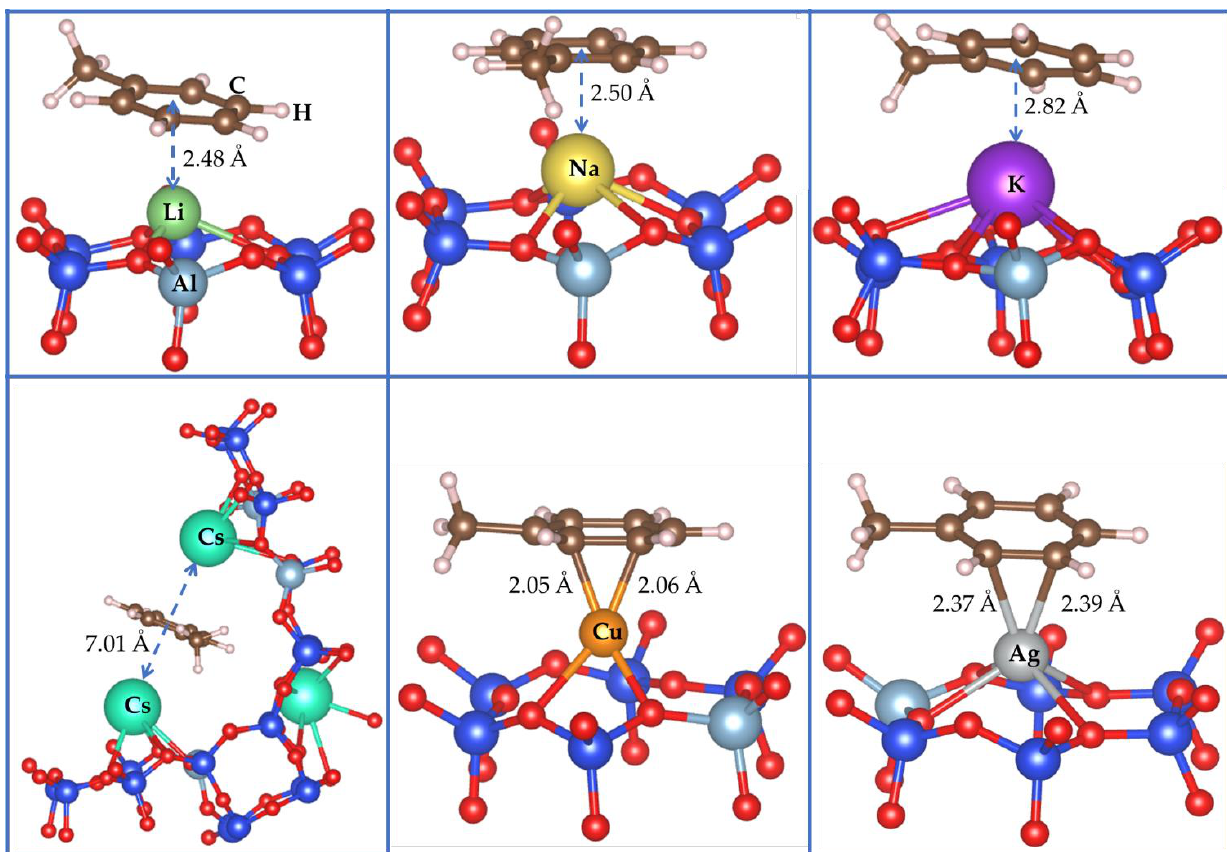
Figure 1. The most stable adsorption modes calculated for toluene over LiY, NaY, KY, CsY, CuY and AgY. For the sake of clarity, only the 6-MR involved in the adsorption process was displayed (One 6-MR of LiY, NaY, KY, CuY and AgY; two 6-MR for